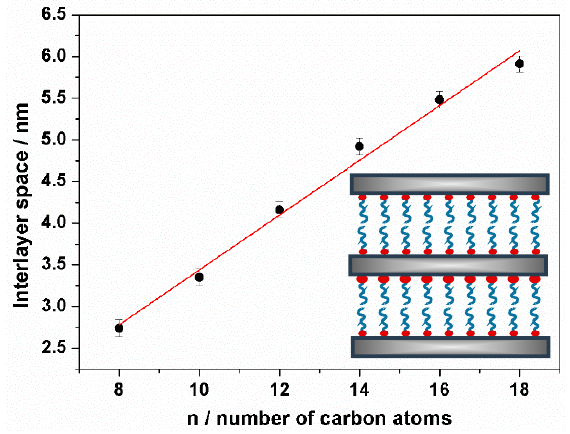
Figure 2. Evolution of the interlayer space vs. the number of carbon atoms in the alkylamine surfactant tail.